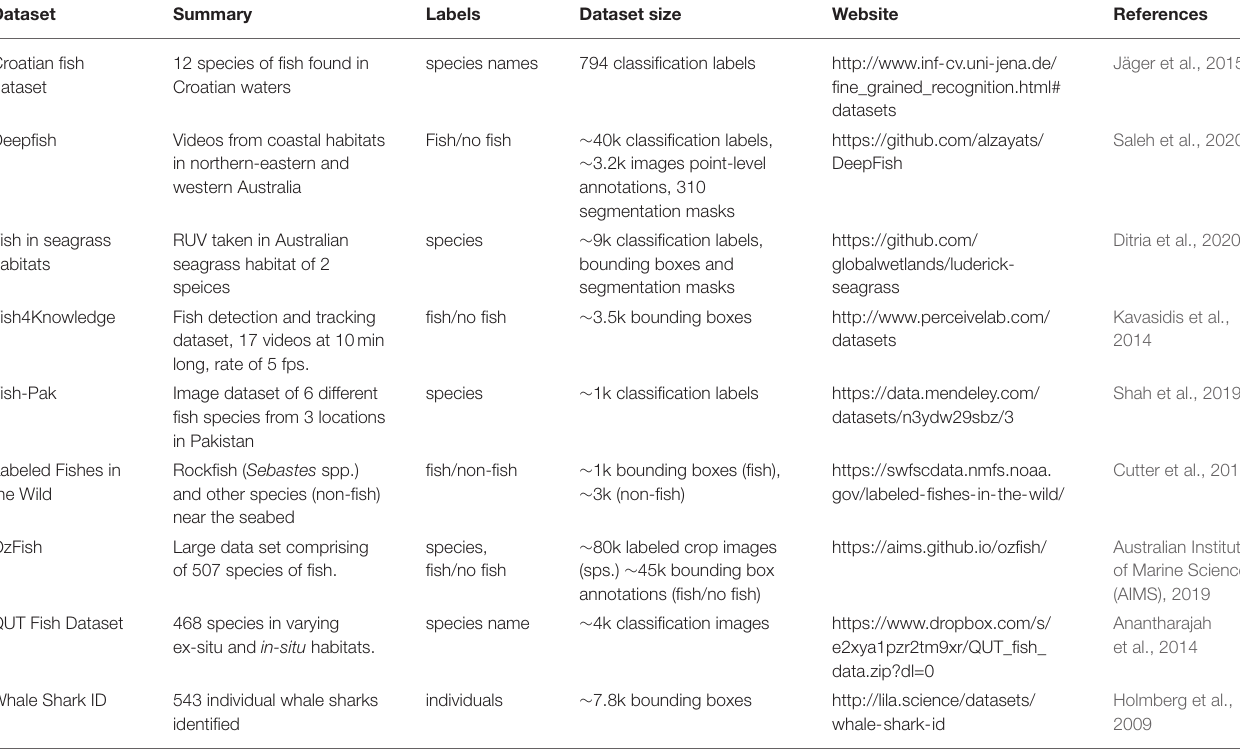
TABLE 1 | Summary of some currently available datasets for training and testing computer vision models for fish.